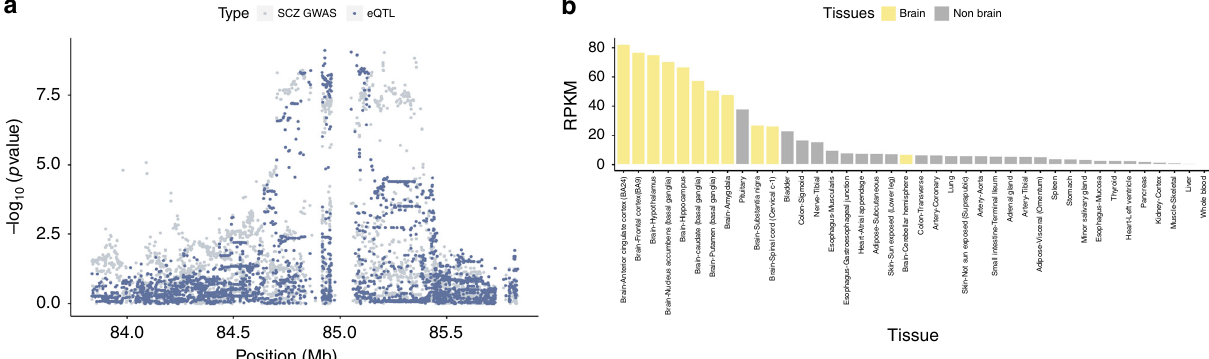
Fig. 5 Annotation-independent approaches yield disease-relevant information. a Colocalisation of the schizophrenia GWAS lead SNP rs950169 (GWAS p value = 7.62 × 10 − 11 ) and the i-eQTL targeting DER36302 (eQTL p value = 1.15 × 10 − 10 in putamen). b Expression of DER36302 across tissues sampled by the GTEx consortium. Brain tissues are highlighted in yellow with the anterior cingulate and frontal cortex showing the highest expression. Source data are provided as a Source Data fi le.